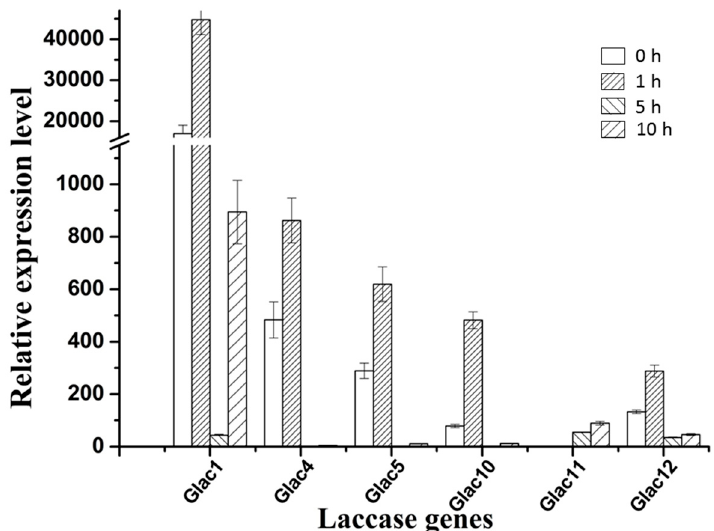
Figure 6. Relative expression levels of six laccase genes of G. lucidum with high expression levels, which were treated with 200 ppm RBBR in 4 different time periods. The value represents the expression percentage of laccase gene accounts for the expression of RPL4. The error bars represent the standard deviation of triplicate samples.